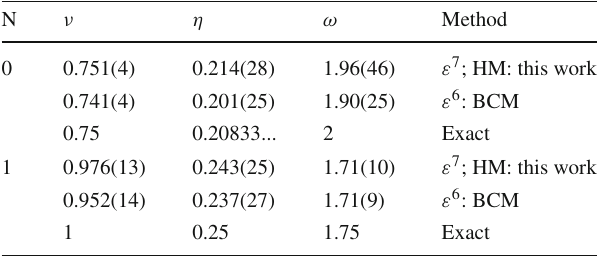
Table 6 The seven-loop ( ε 7 ) hypergeometric-Meijer resummation for the exponents ν , η and ω for the Self-avoiding walks ( N = 0) and the Ising-like model ( N = 1) in two dimensions ( ε = 2). For comparison with other predictions, we list the results from BCM algorithm [32] for six loops. Exact results for N = 1 for ν and η are obtained in the seminal article in Ref. [57] and ω from Ref. [58]. For N = 0, exact values for ν,η and ω are conjectured in Ref.